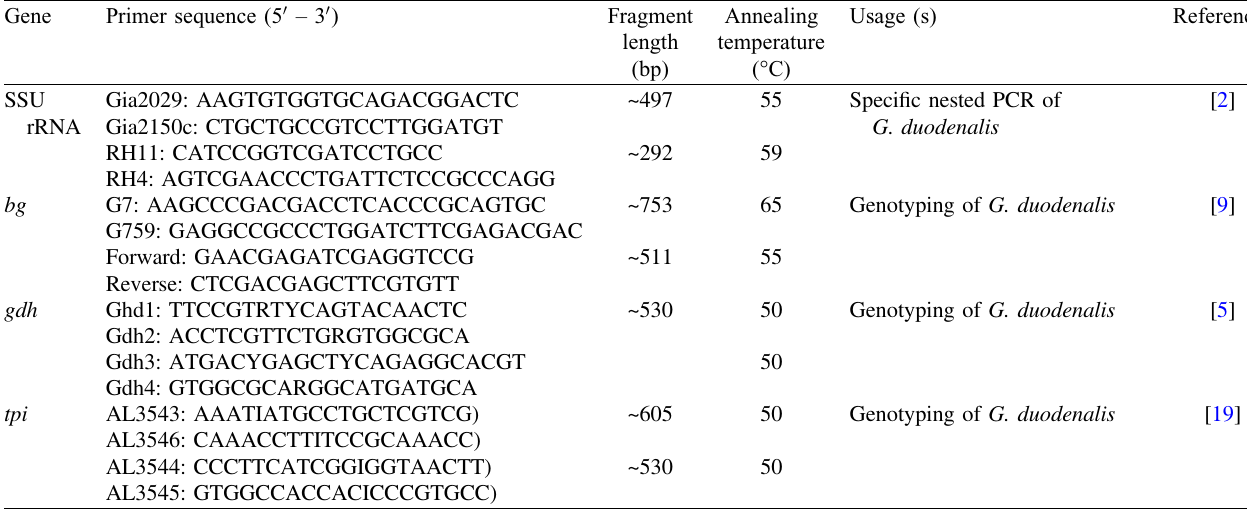
Table 1. The primers used in the characterization of G. duodenalis in the present study. Gene